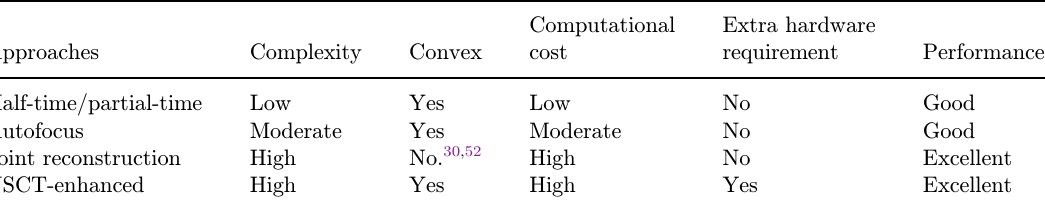
Table 1. Performance comparison of the four approaches for acoustic heterogeneity